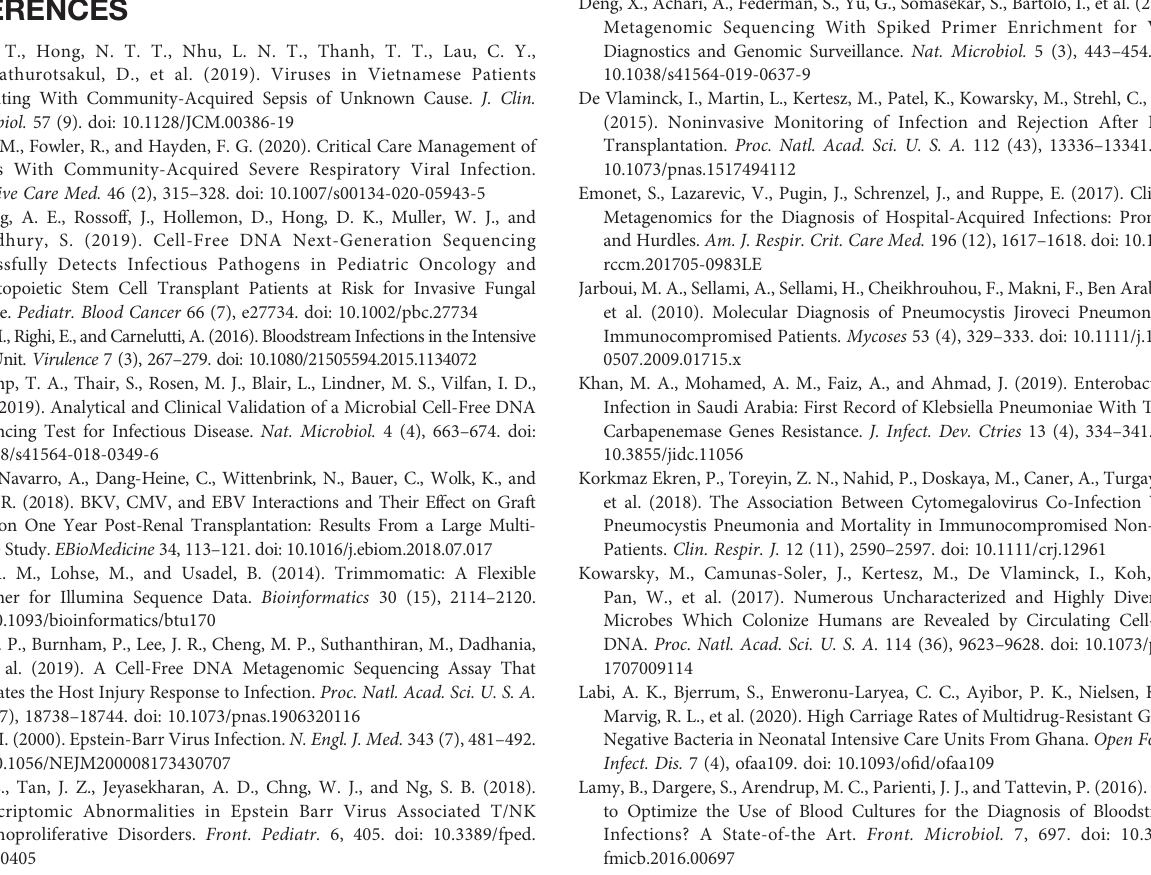
Supplementary Figure 2 | Correlation analysisofbloodstream pathogenic fungi andclinicalphenotypesofchildreninPICU. (A) Numbersof Pneumocystisjirovecii inthe